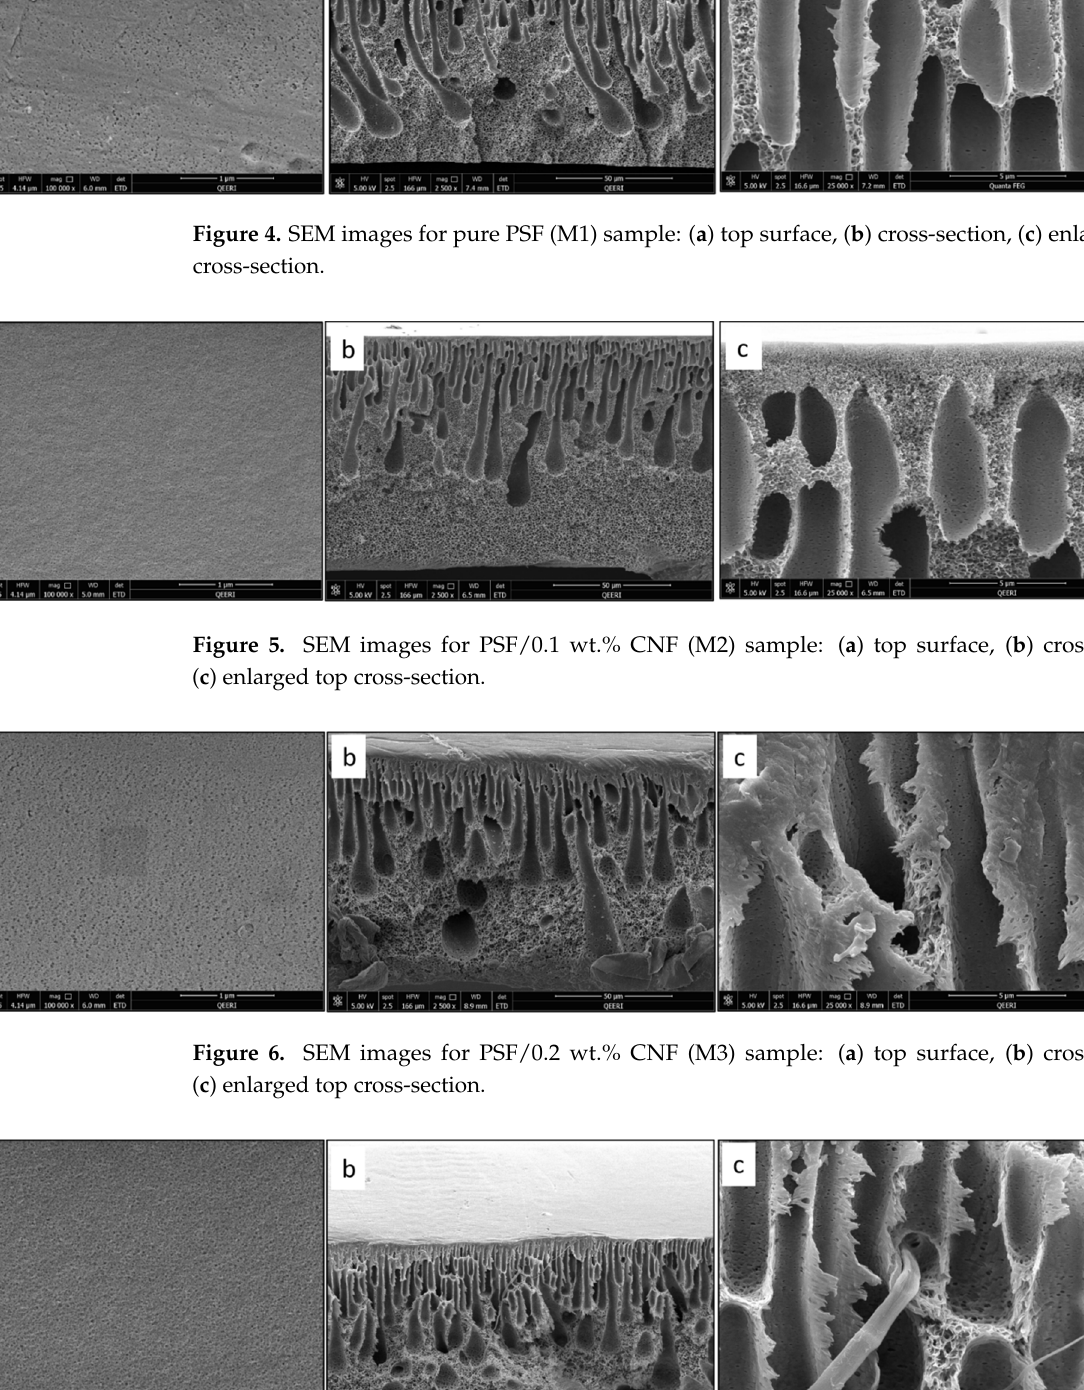
Figure 7. SEM images for PSF/0.3 wt.% CNF (M4) sample: ( a ) top surface, ( b ) cross-section, ( c ) en- larged top cross-section.